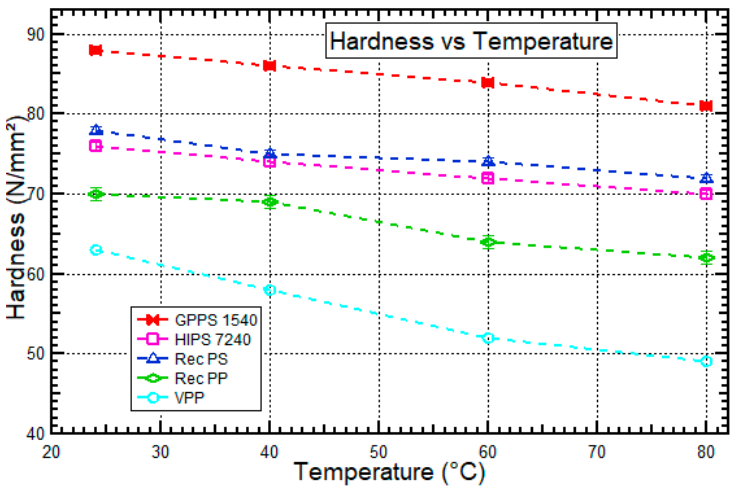
Figure 8. Hardness vs. temperature behavior for HIPS 7240, GPPS 1540, recycled PS, recycled PP, and virgin PP at 24 °C, 40 °C, 60 °C, and 80 °C. Data for virgin PP was obtained from Sahin et al. [52].